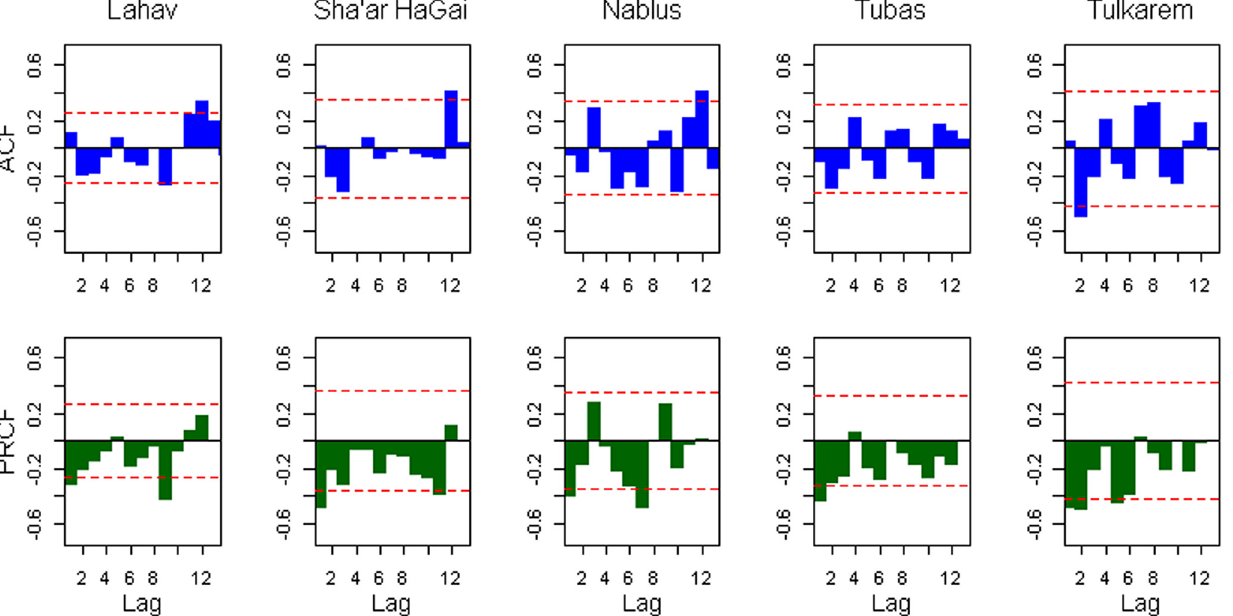
Fig 4. Autocorrelation functions. Autocorrelation functions (ACF, blue) and partial rate correlation functions (PRCF, green) on the de-trended rate of population change (Rt) of the olive fly in the Eastern Mediterranean region. Broken red lines depict the 95% confidence interval for the